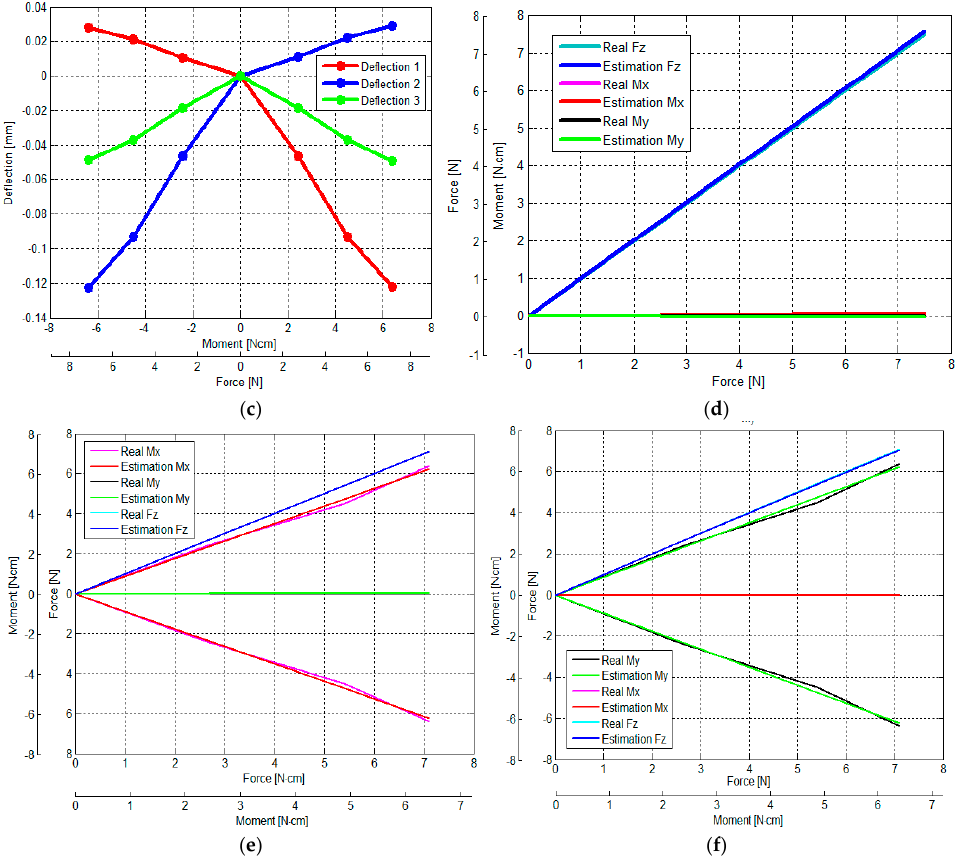
Figure 10. The simulation results describing simply-supported beam deflections and sensor’s accuracy and crosstalk evaluation: ( a ) when F z is applied on the upper plate, the simply-supported beam deflects around δ = 0.05 mm (see also Figure 9a); ( b ) when Force F z and Moment M x are applied on the upper plate, the simply-supported beam deflects around δ = 0.15 mm as shown (see also Figure 9b); ( c ) when Force F z and Moment M y are applied on the upper plate, the simply-supported beam deflects around δ = 0.15 mm (see also Figure 9c); ( d ) when F z is applied on the upper plate maximum error F z is around 1% and crosstalk M x and M y are less than 0.5% (the sensor accuracy and crosstalk simulated by FEM simulation) (see also Figure 9a); ( e ) similarly when Force F z and Moment M x are applied on the upper plate, maximum error M x is around 3% and crosstalk M y is less than 0.5% (see also Figure 9b); and ( f ) when Force F z and Moment M y are applied on the upper plate, maximum error M y is around 3% and crosstalk M x is less than 0.5% (see also Figure